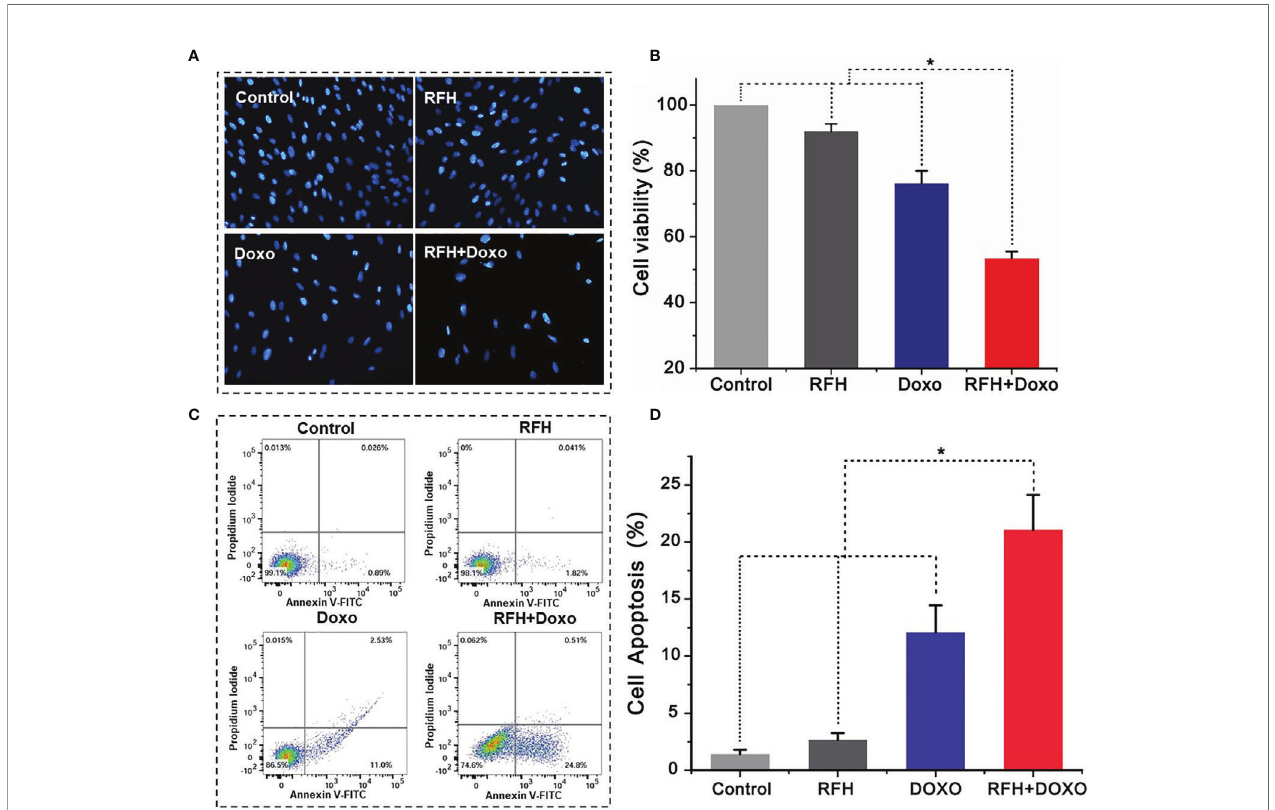
FIGURE 4 | In vitro experiments on therapeutic effect among different treatments groups. (A) Microscopy shows an obvious decrease of viable cells in the RFH + Doxo group, compared to other control groups. (B) MTS assay further con fi rms that RFH-enhanced chemotherapy results in the lowest cell viability, compared to other control treatments [Doxo+RFH (53.47 ± 2.01%) vs Doxo (76.23 ± 3.80%), RFH (92.03 ± 2.24%), and saline (100%); P<0.05, n=6 per group]. (C) The combination therapy group displays the highest percentage of apoptotic cells. (D) Quantitative analysis of fl ow cytometry, demonstrating signi fi cant increase in